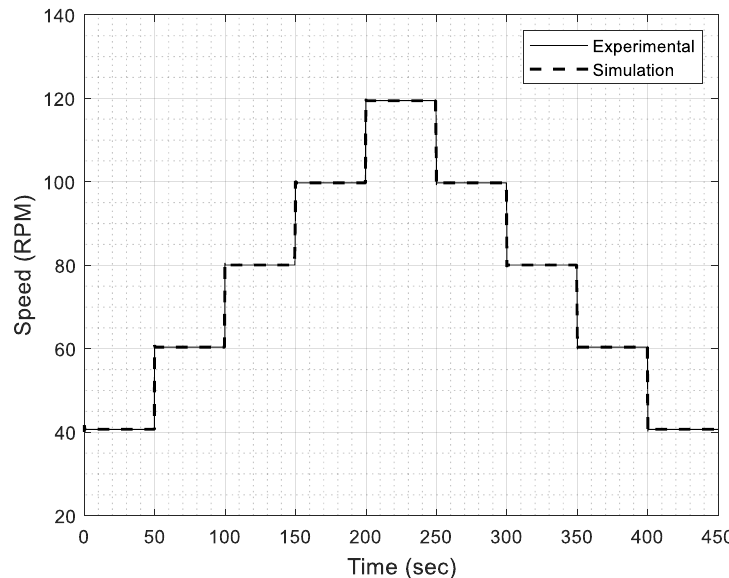
Table 1. Values of the DC motor’s variables.